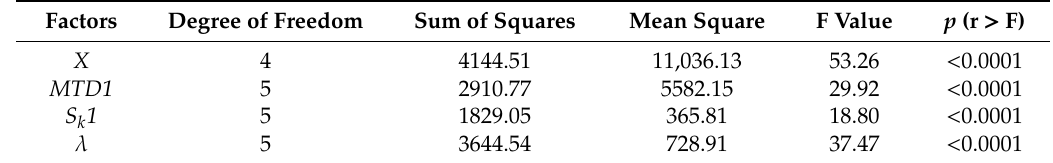
Table 5. Factor test results of final BPN